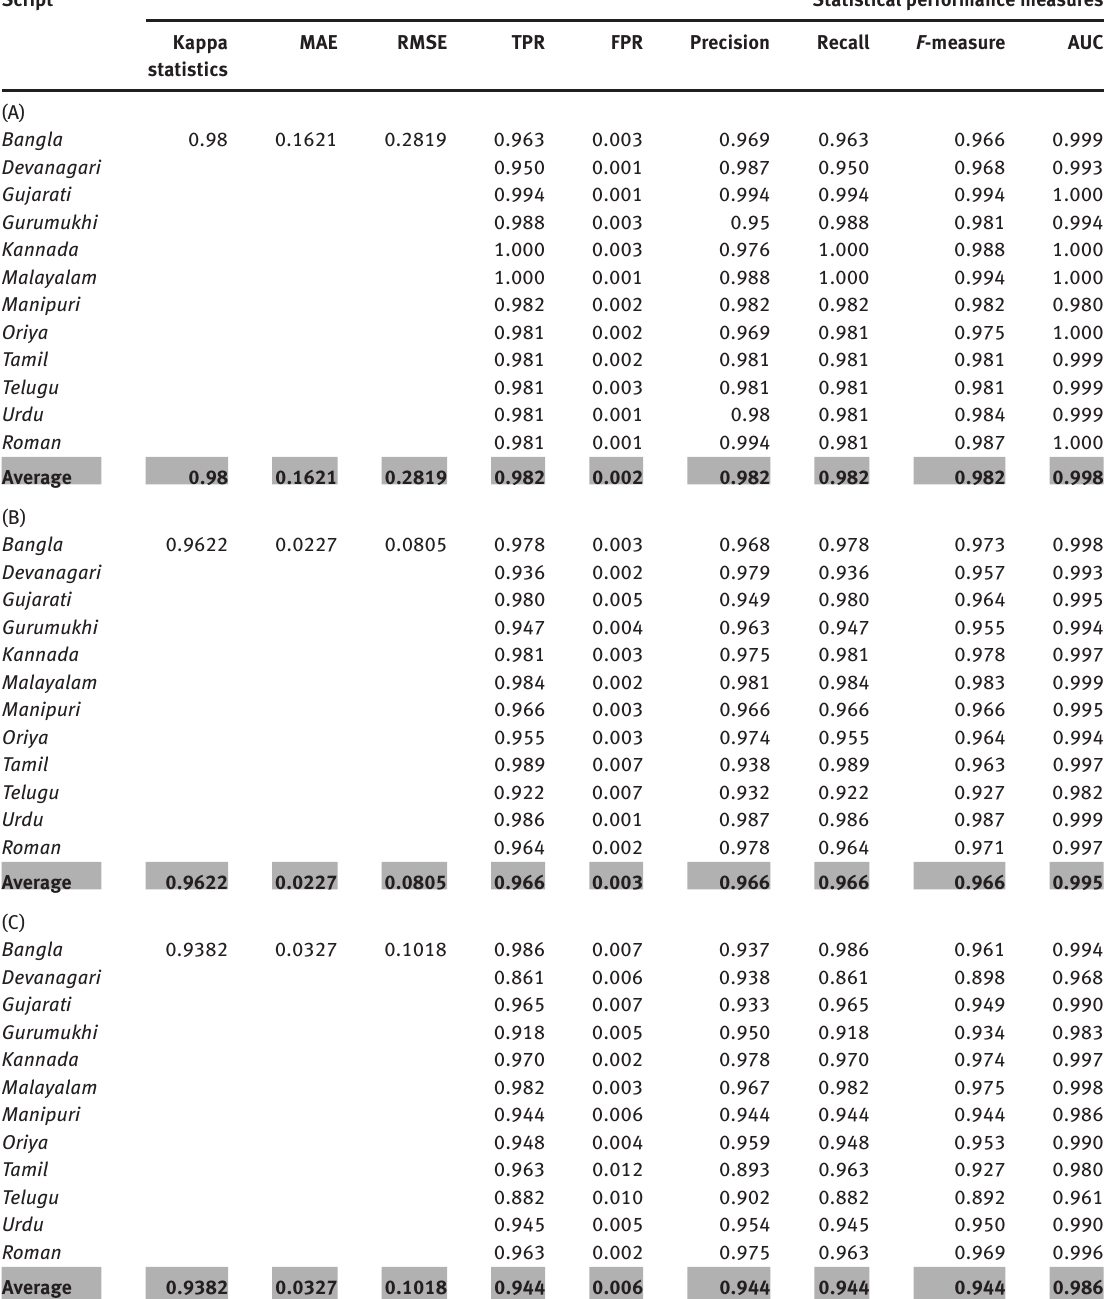
Table 2: Statistical Performance Measures along with Their Respective Means (Styled in Bold and Shaded in Gray) Achieved for Best Case of the SVM Classifier on 12 Different Scripts at (A) Second-Level, (B) Third-Level, and (C) Four-Level Page